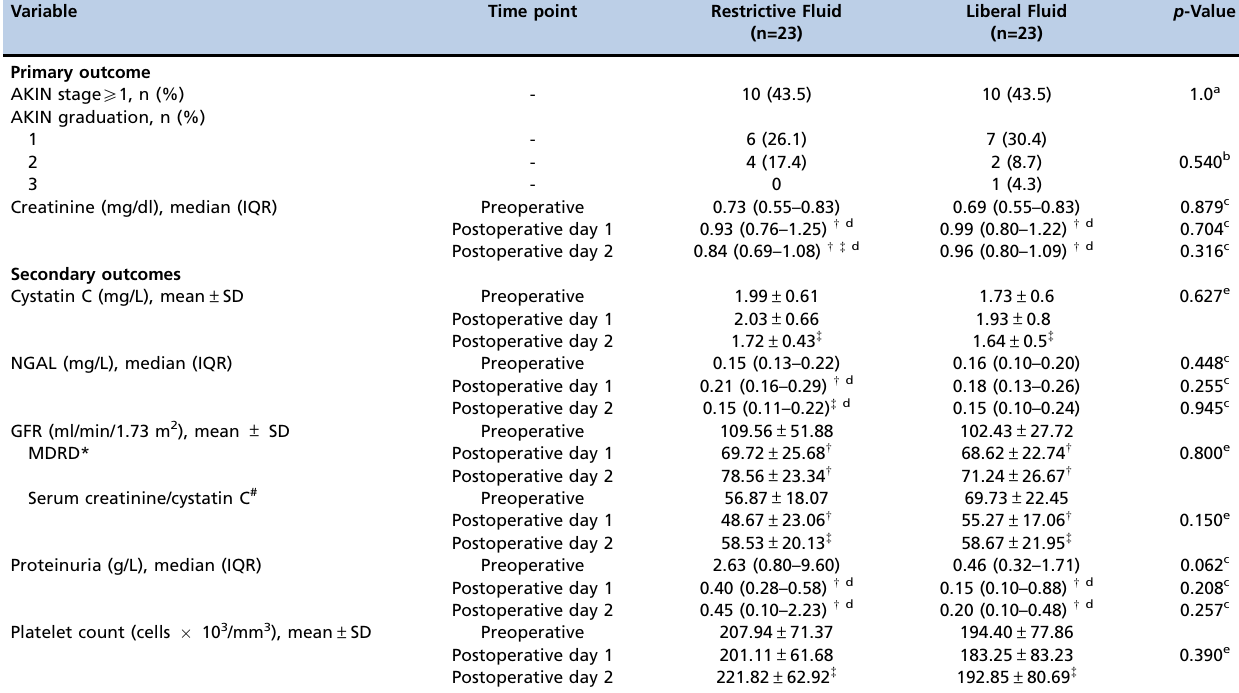
Table 3 - Primary and secondary